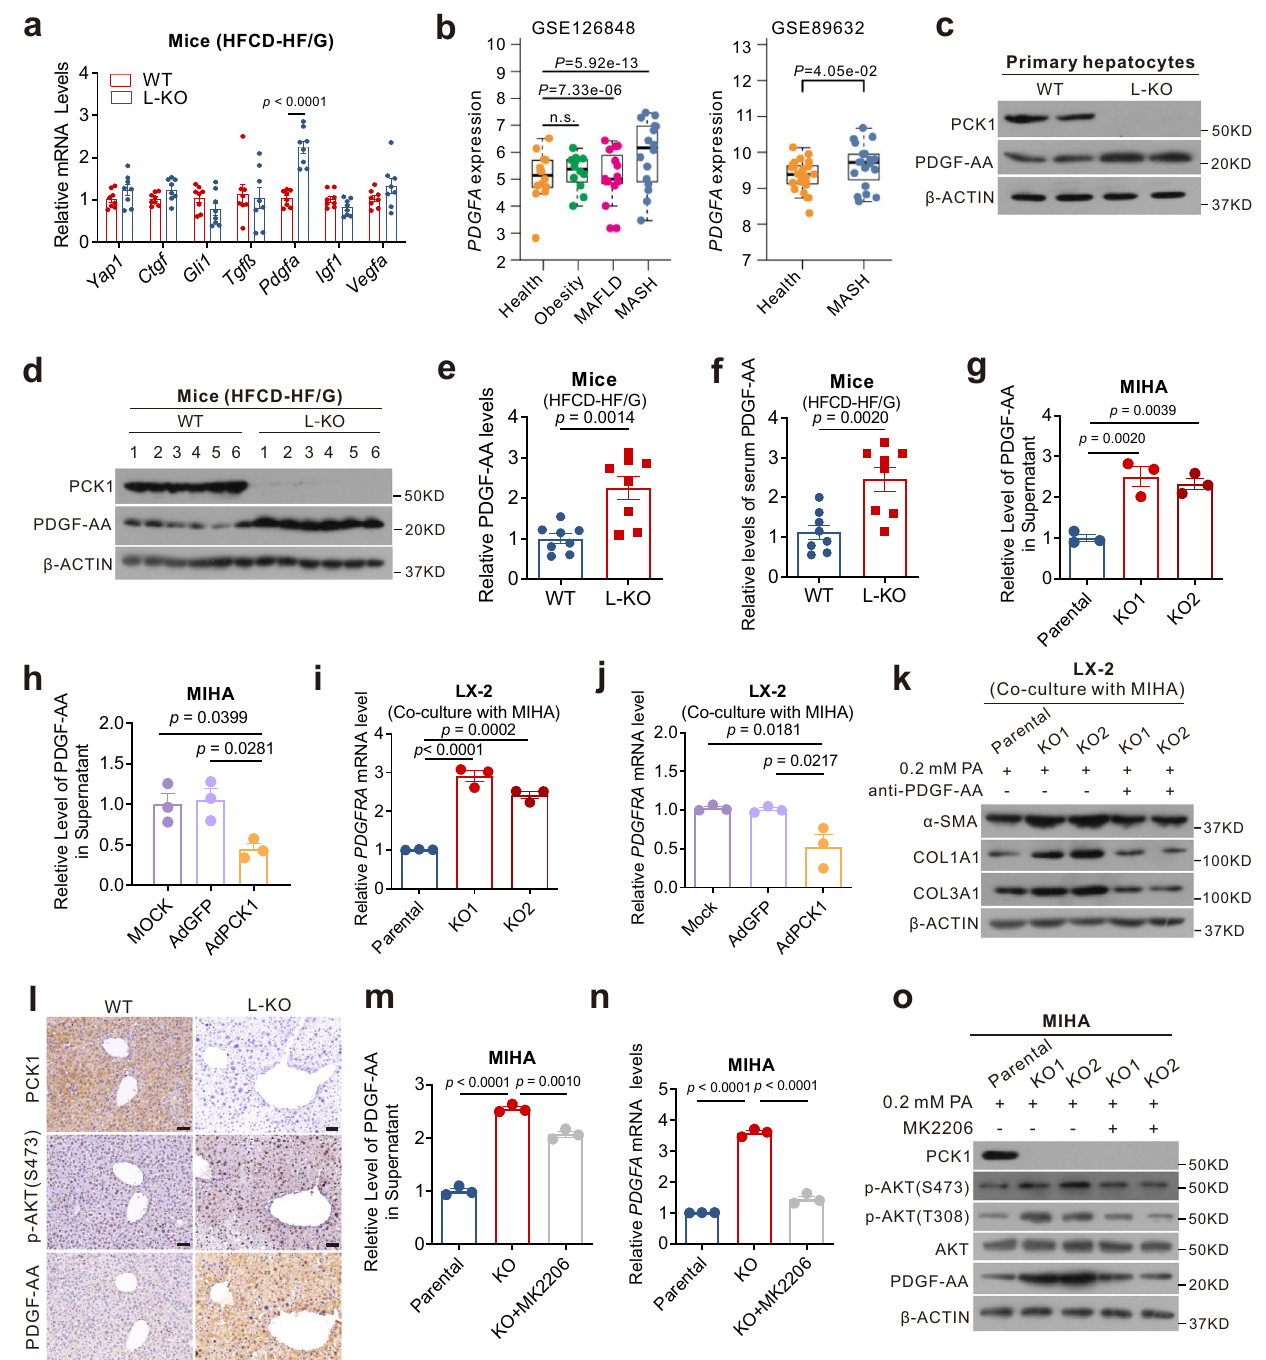
Fig. 6 | Paracrine PDGF-AA from hepatocytes promotes hepatic stellate cell (HSC) activation. a Expression levels of genes related to fi brogenesis ( n =8 for each group). b Relative PDGFA mRNA levels of health ( n =14), obesity ( n =12), NAFLD ( n =15), and NASH ( n =16) in GSE126848 and of health ( n =19), and NASH ( n =24) in GSE89632 datasets. The box plots show the medians (middle line) and the fi rst and third quartiles (boxes),whereas the whiskers show1.5×the IQR above andbelowthebox.Unpaired,two-sidedMann – WhitneyUtest P valuesaredepicted intheplots,andthesigni fi cant P valuecutoffwassetat0.05. c,d PDGF-AAprotein levels in primary hepatocytes ( c ) or liver tissues ( d ) detected by western blotting. Thesampleswerederivedfromthesameexperimentandtheblotswereprocessed in parallel. e, f PDGF-AA levels in liver tissues ( e ) or serum ( f ) were detected using enzyme-linked immunosorbent assay (ELISA) ( n =8). g , h Secreted PDGF-AA levels in conditioned medium with PCK1 -KO ( g ) or PCK1 -OE ( h ) MIHA cells treated with